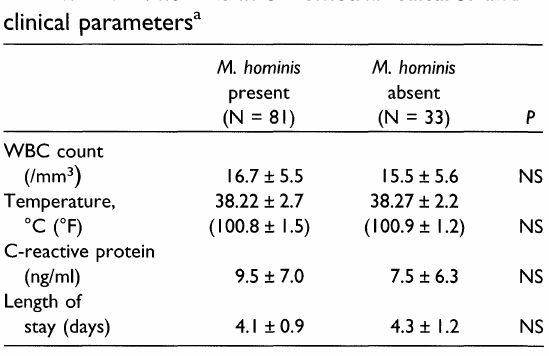
TABLE 2A. M. hominis in endometrial cultures and clinical parameters